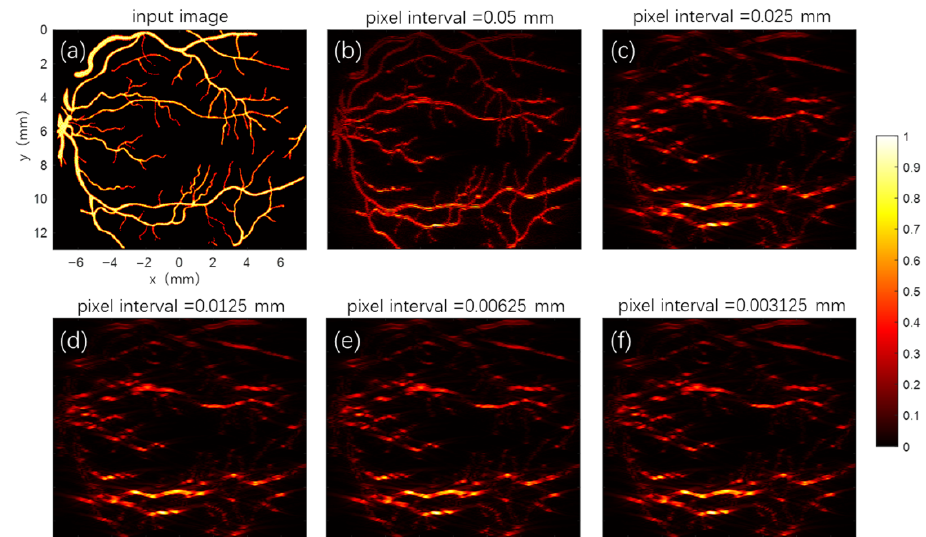
Figure 5. The reconstructed results of a digital blood vessel network with different pixel intervals of the input image. ( a ) The input digital blood vessel network and ( b – f ) the reconstruction results given by the STR-BP method when the pixel interval of the input image was 1, 2, 4, 8, 16 times 0.05 mm, respectively.